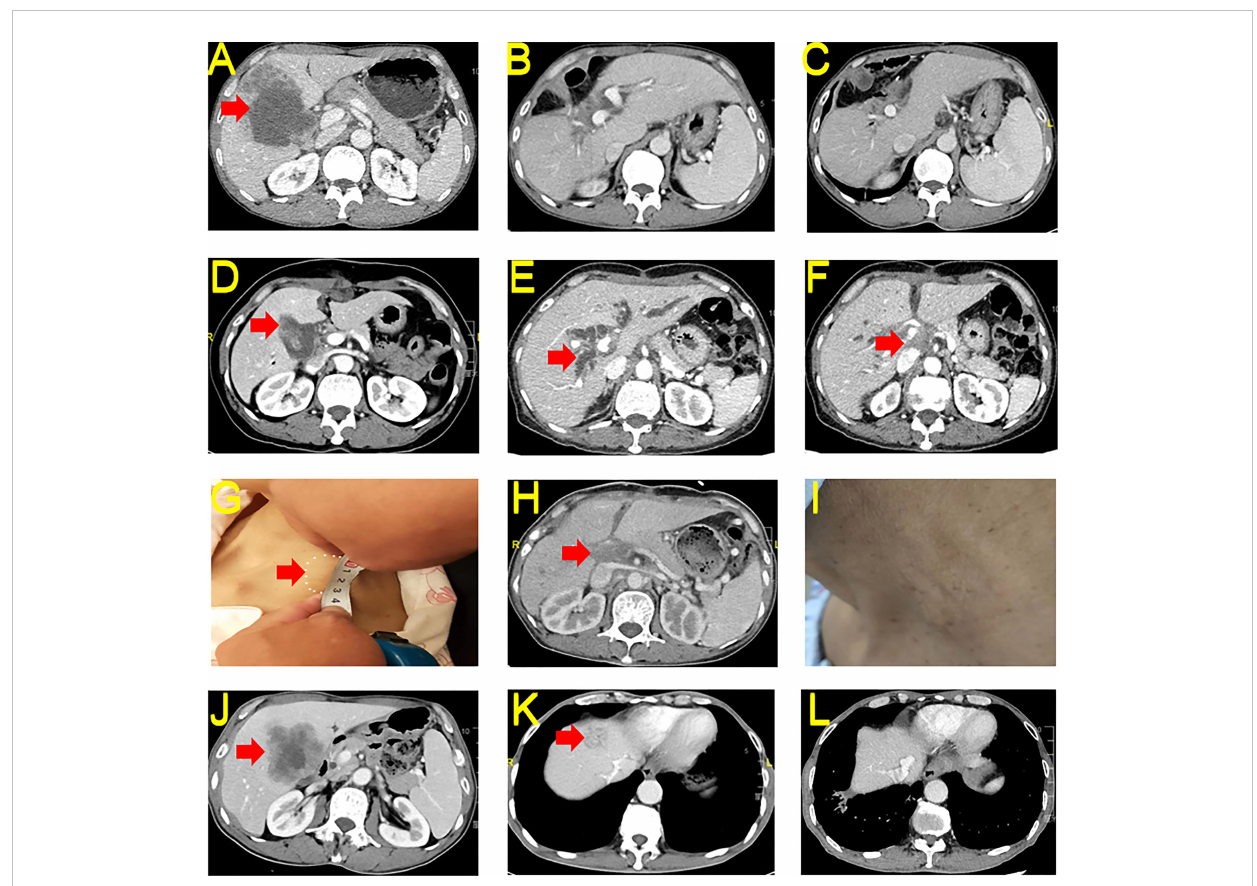
FIGURE 3 CECT and Macroscopy for Case 3-5. (A) Preoperative tumor conditions of case 3. (B) Postoperative 6 months reexamination of case 3. (C) Postoperative 18 months reexamination of case 3. (D) Preoperative tumor conditions of case 4. (E) Postoperative progression and bile duct dilatation of case 4. (F) Postoperative progression and hilar soft tissue effects of case 4. (G) Postoperative neck metastasis of case 4. (H) Hilar soft tissue shadow slightly reduced after immunotherapy in case 4. (I) Neck tumor disappeared after immunotherapy in case 4. (J) Preoperative tumor conditions of case 5. (K) Postoperative intrahepatic metastasis of case 5. (L) Intrahepatic metastases reduced after immunotherapy in case 5. CECT, contrast-enhanced computed tomography; HE, hematoxylin and eosin; PD-L1, Programmed Cell Death-Ligand